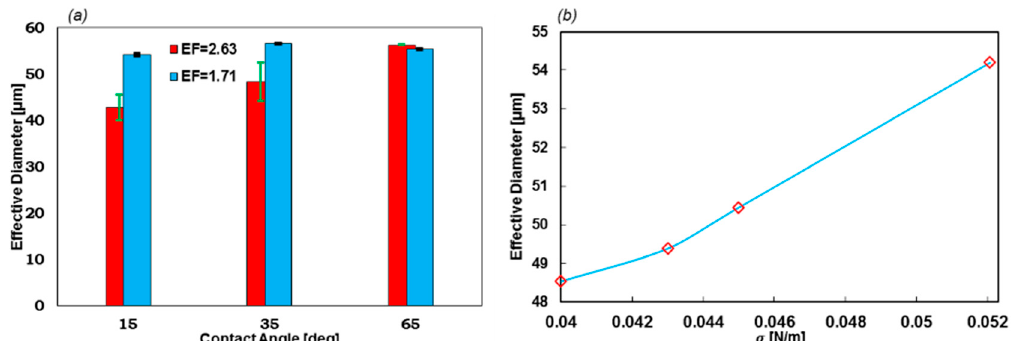
Figure 9. ( a ) The effect of the geometrical EF on the droplet formation stability and size with respect to different contact angles ( σ = 0.05207 N/m]) and ( b ) droplet diameters with respect to σ . The greater the surface tension coefficient, the larger the droplets.